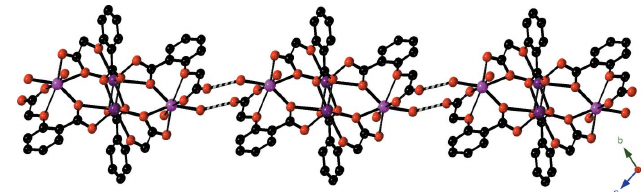
Figure 6 Supramolecular layer in the title compound, oriented parallel to (011).